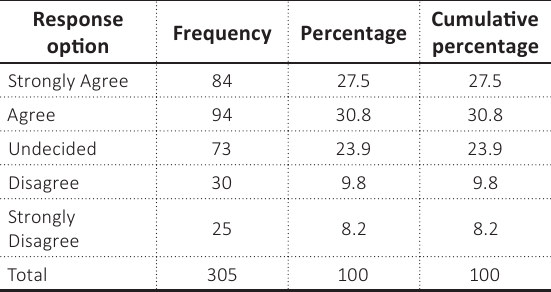
pleasant or safe